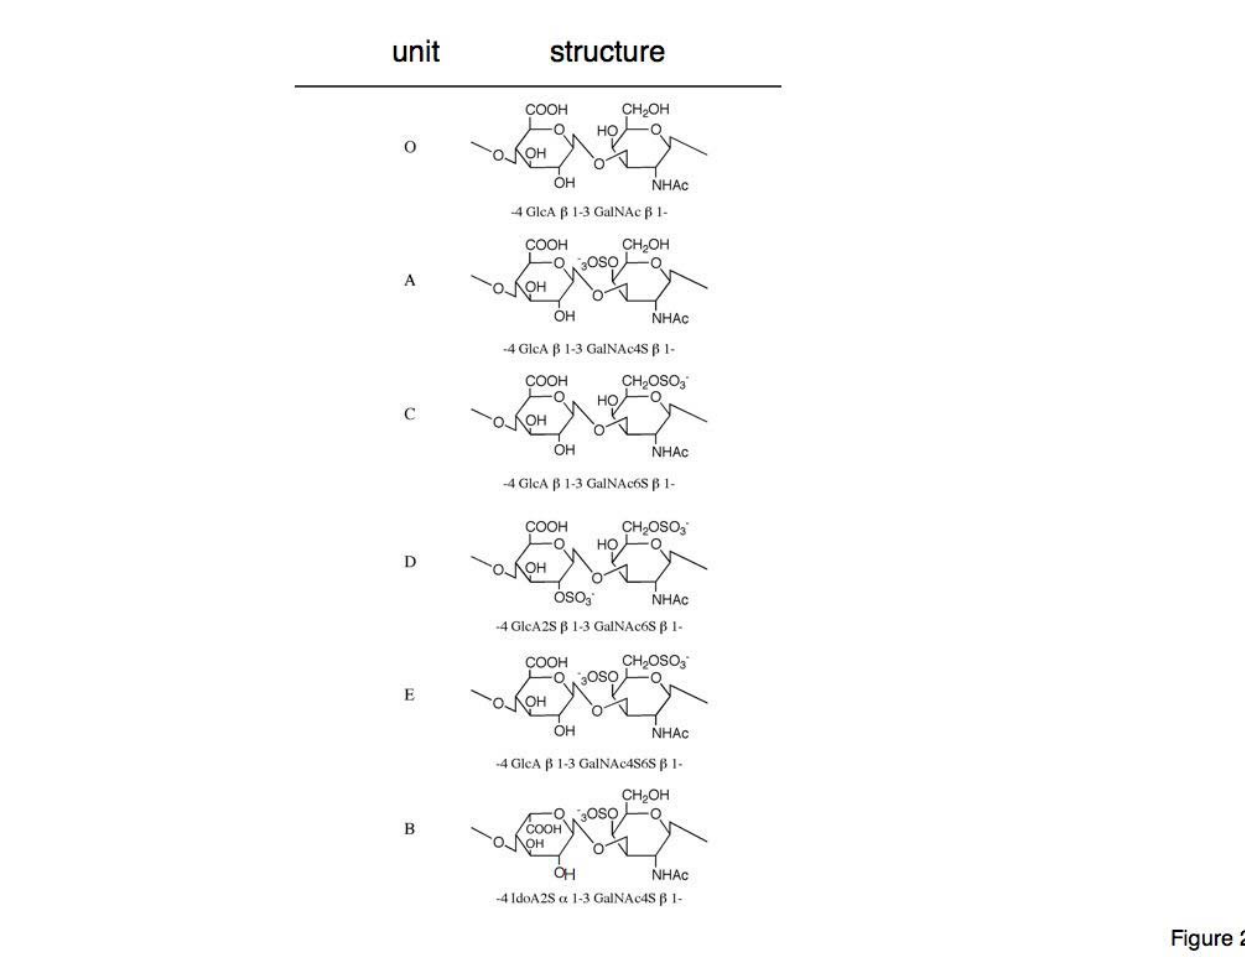
Figure 2. Schematic representation of chondroitin sulfate (CS) units’ structures. CS is made up of unbranched polysaccharides composed of repeating units of disaccharide (glucuronic acid and N-acetylgalactosamine) that are classified into O-, A-, B-, C-, D-, and E-units depending on sulfation sites; the structural diversity of CS results from variable combinations of these units. ( A )-unit of CS [GlcA β 1-3GalNAc(4-O-sulfate)]; ( C )-unit of CS [GlcA β 1-3GalNAc(6-O-sulfate)]; ( D )-unit of CS [GlcA(2-O-sulfate) β 1-3GalNAc(6-O- sulfate)]; ( E )-unit of CS [GlcA β 1-3GalNAc(4,6-O-disulfate)]; ( B )-unit of CS is an